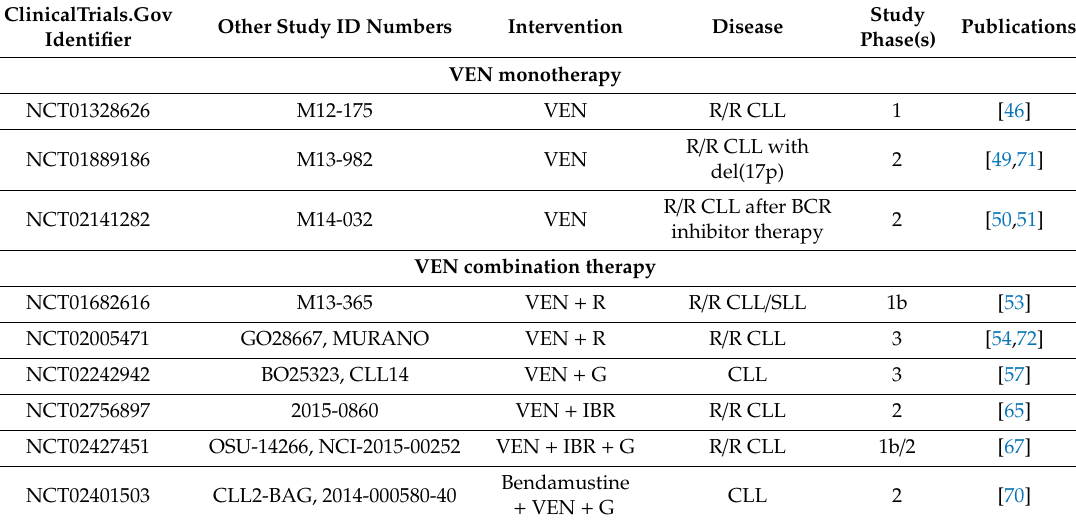
Table 1. Selected clinical trials of venetoclax in chronic lymphocytic leukemia (CLL). ClinicalTrials.Gov